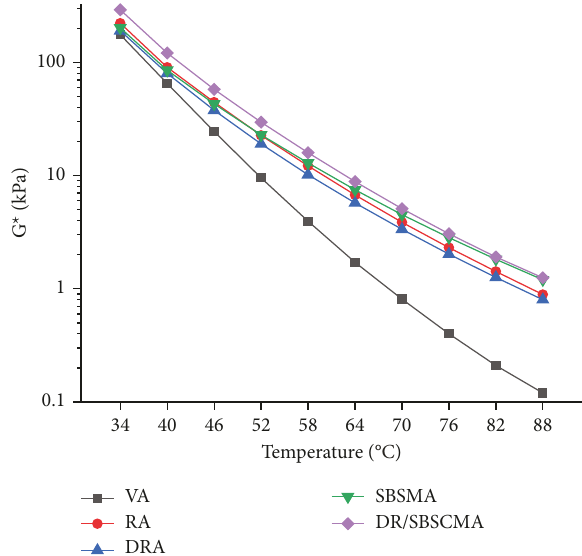
Figure 6: Relationship between complex shear modulus and temperature.